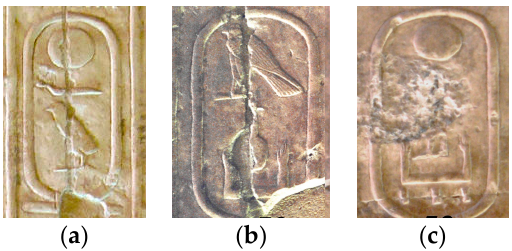
Figure 14. The effects of time, exposure and even vandalism make the recognition process difficult. Khufu’s cartouche; ( b ) Neferkahor’s cartouche; ( c ) Qakare Ibi’s